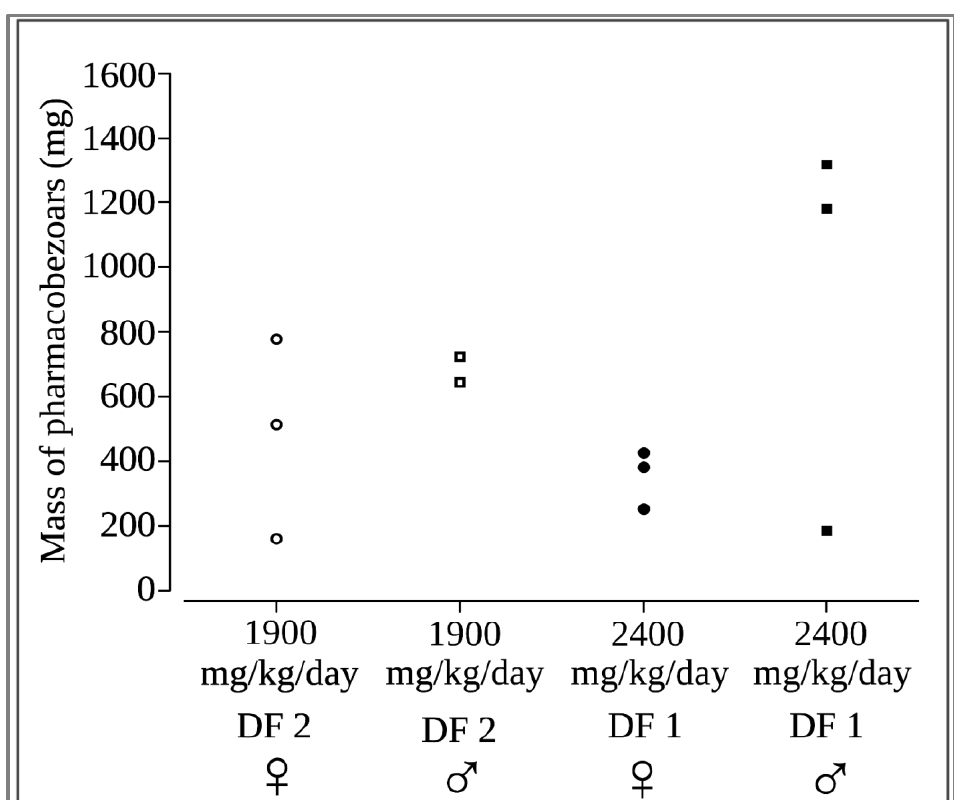
Figure 6. Total mass of all pharmacobezoars observed per rat in the dose finding study ( ♀ : female; ♂ : male).